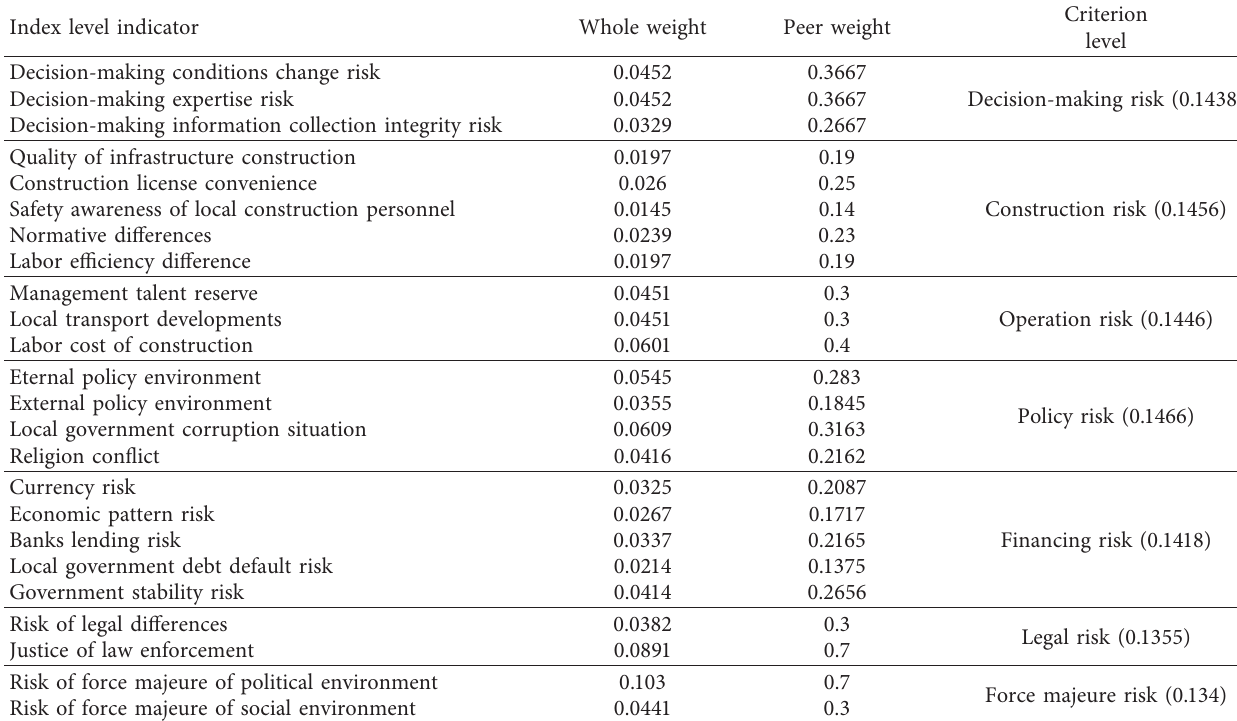
Table 4: Weight calculation